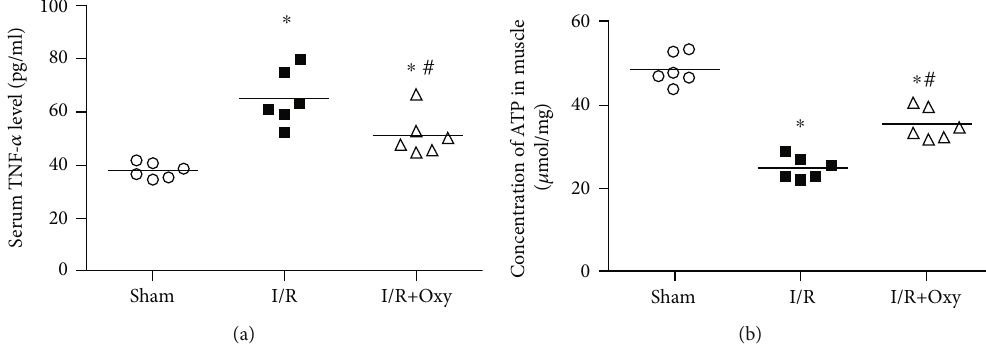
Figure 4: Oxy treatment attenuated alteration of TNF- α and ATP concentration induced by tourniquet placement. (a) Serum TNF- α level. (b) Concentration of ATP in gastrocnemius muscles. I/R: ischemia-reperfusion ( n = 6 in each group); ∗ P < 0 : 05 vs. sham; # P < 0 : 05 vs. I/R. Oxy: oxycodone.